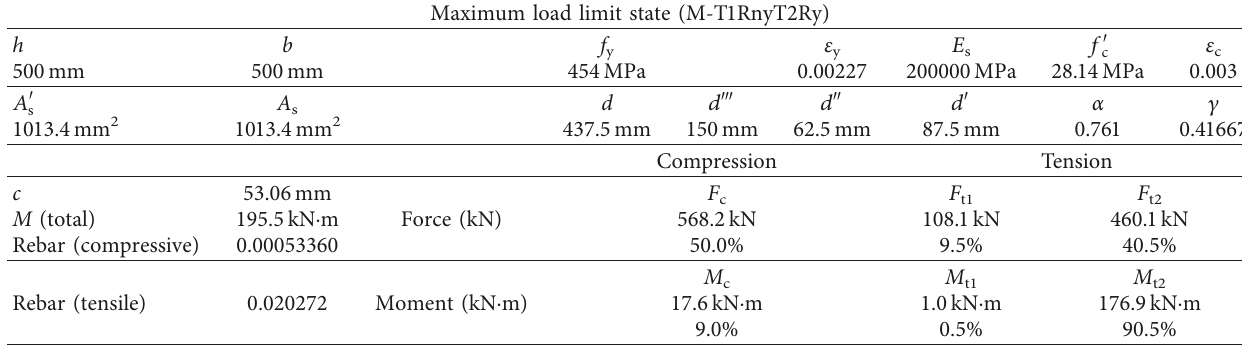
Table 7: Flexural moment capacity at the maximum load state (Specimen #1) [19].